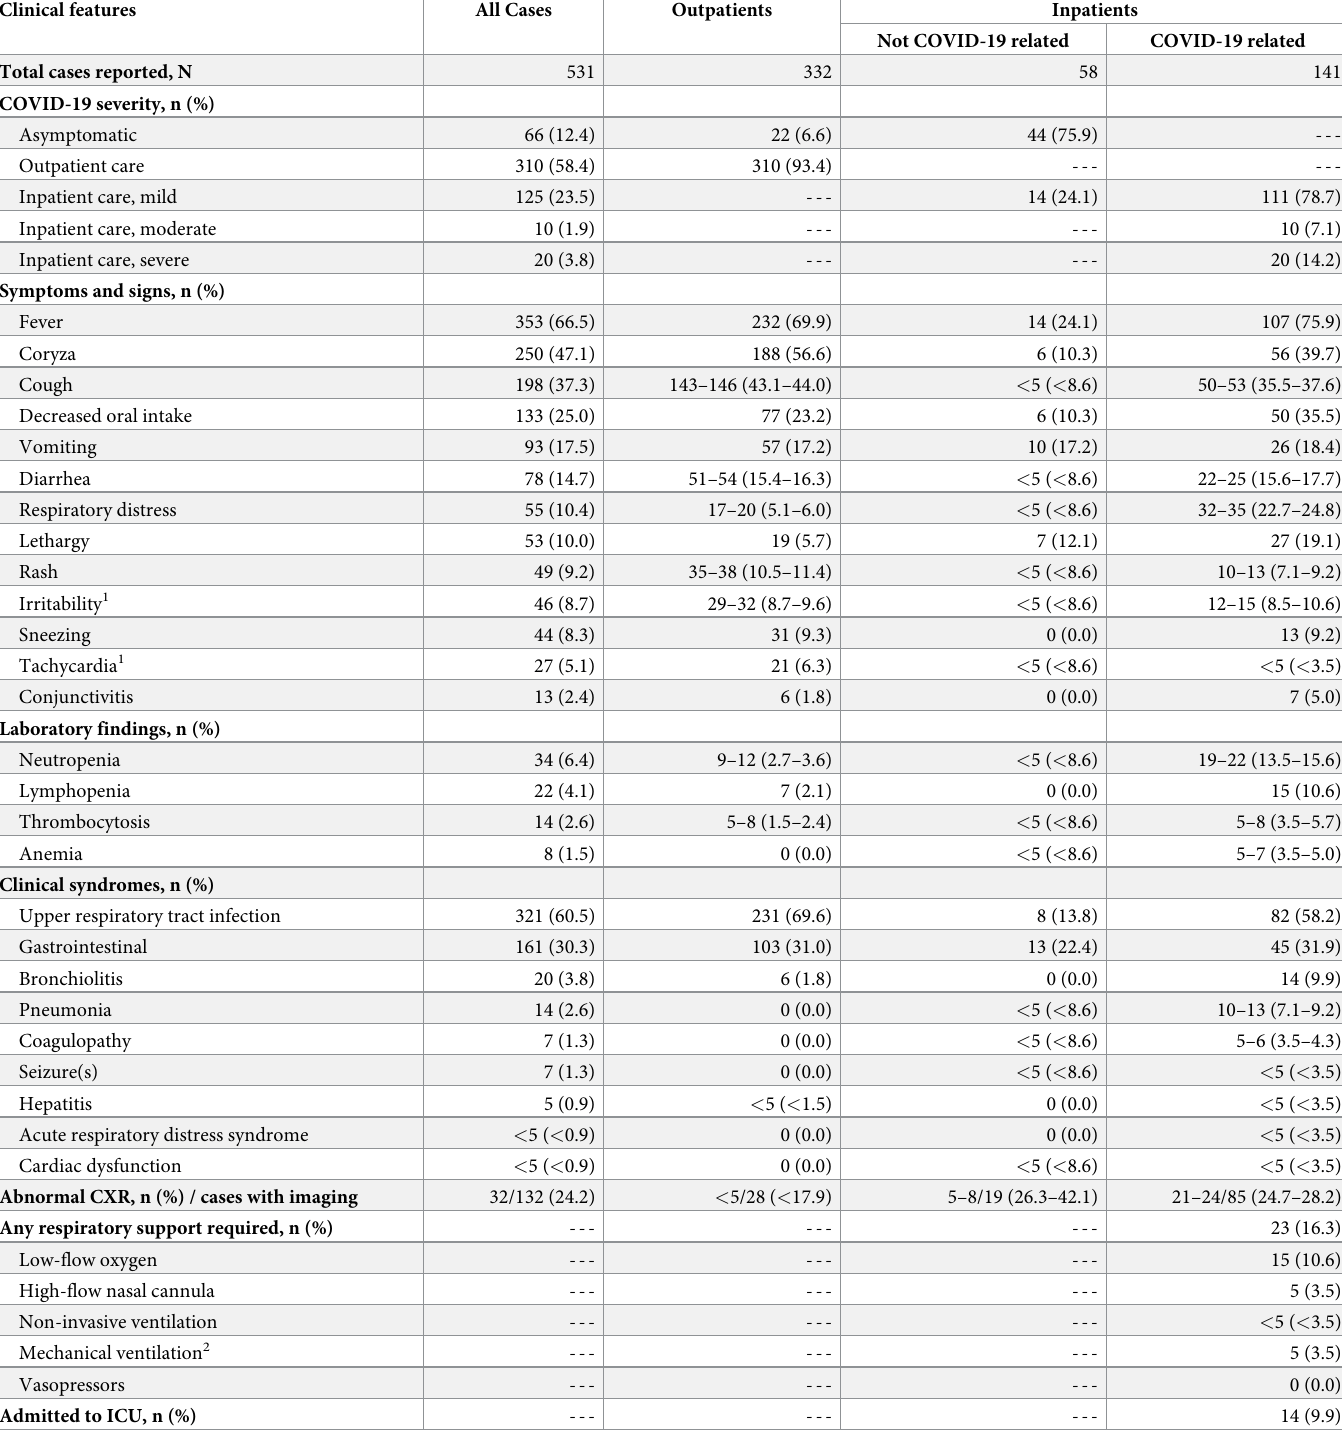
Table 3. Symptoms, laboratory findings, and clinical syndromes of infants with SARS-CoV-2